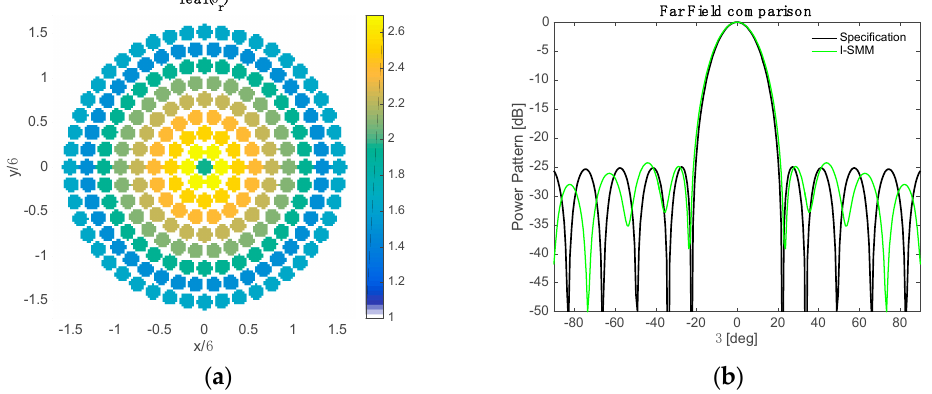
Figure 4. Synthesis of permittivity values for a GAM R -based lens with unknown radius [ τ = − 1.2995 + j0.6573]. ( a ) Real part of the permittivity function; ( b ) radiated far field.